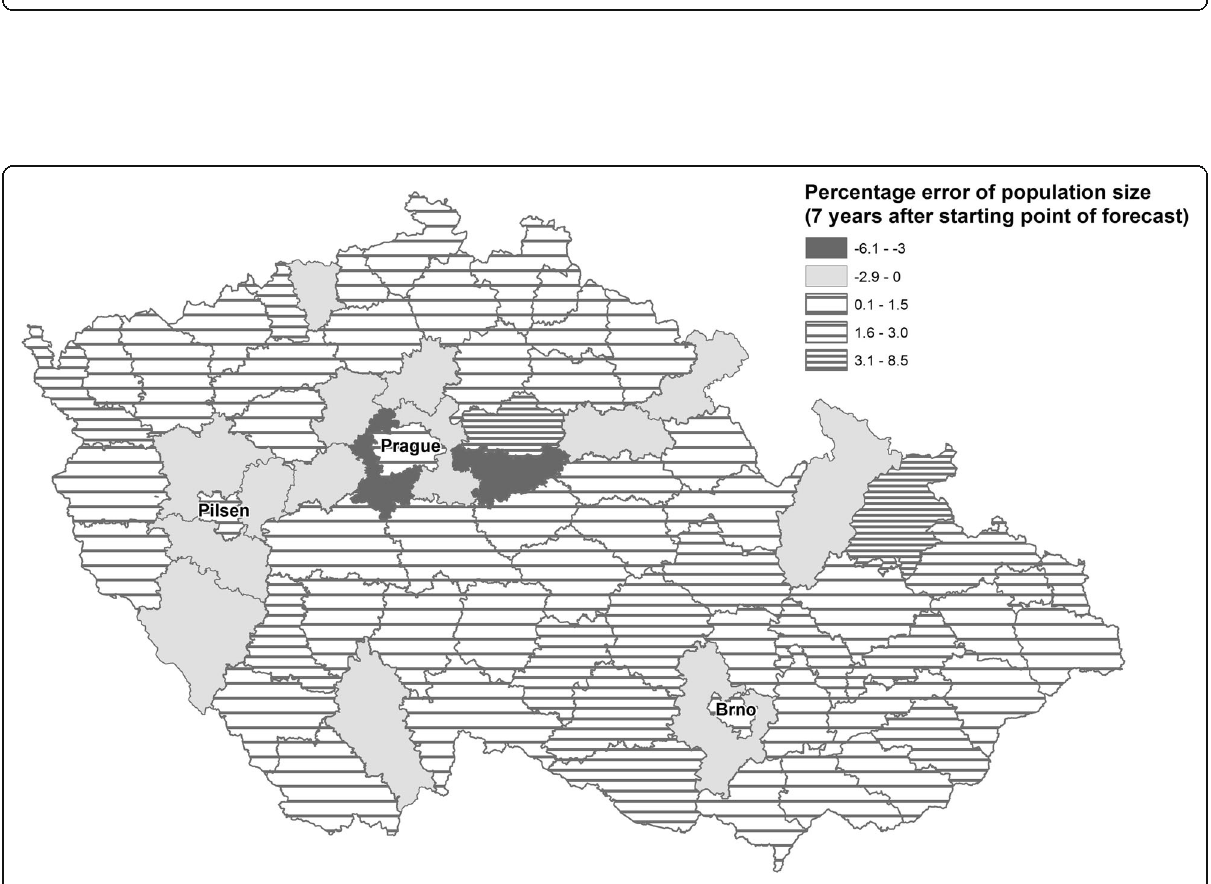
Fig. 3 Percentage error of population size by age in regions of the Czech Republic. Source: [15], authors ’ simulation. Note: regions existing in the 1990s, calculated for year 2000 (7 years after threshold)